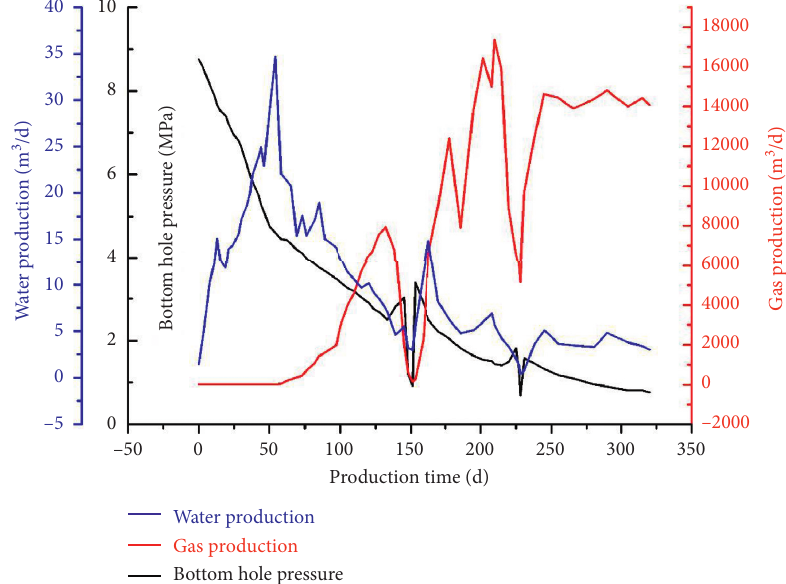
Figure 6: Production curve of well Z5P-01L.